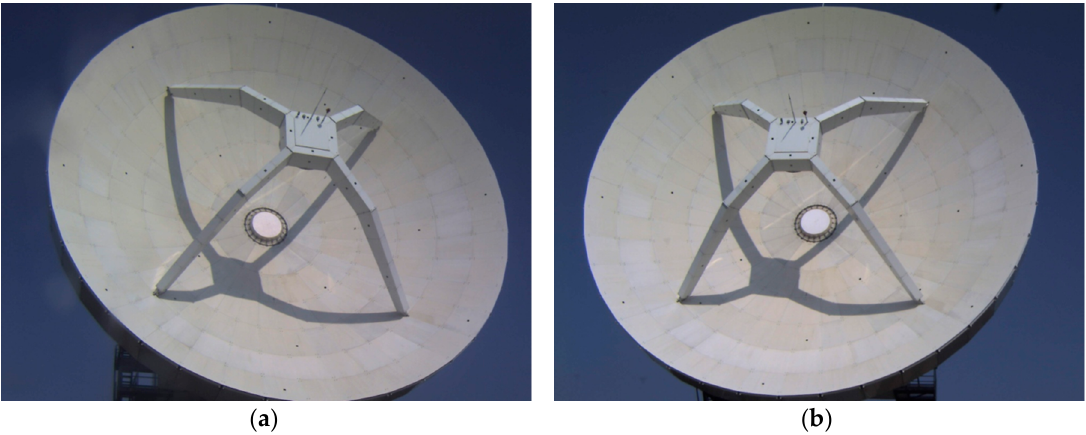
Figure 6. Stereo images of the main reflector of VLBI antenna taken by the Charge Coupled Device (CCD) cameras. ( a ) the first image; ( b ) the second image.